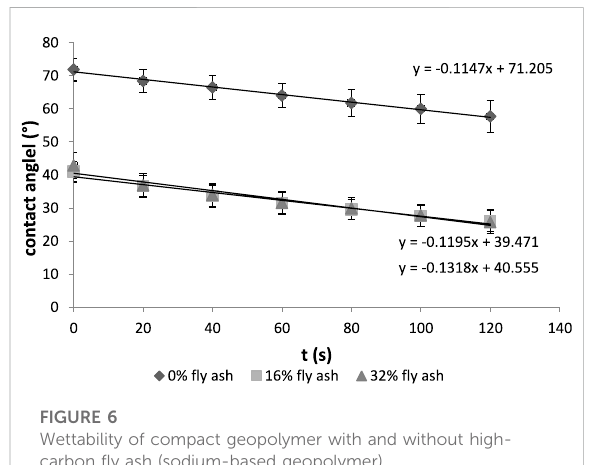
FIGURE 8 Wettability of compact geopolymer samples made from sodium and potassium